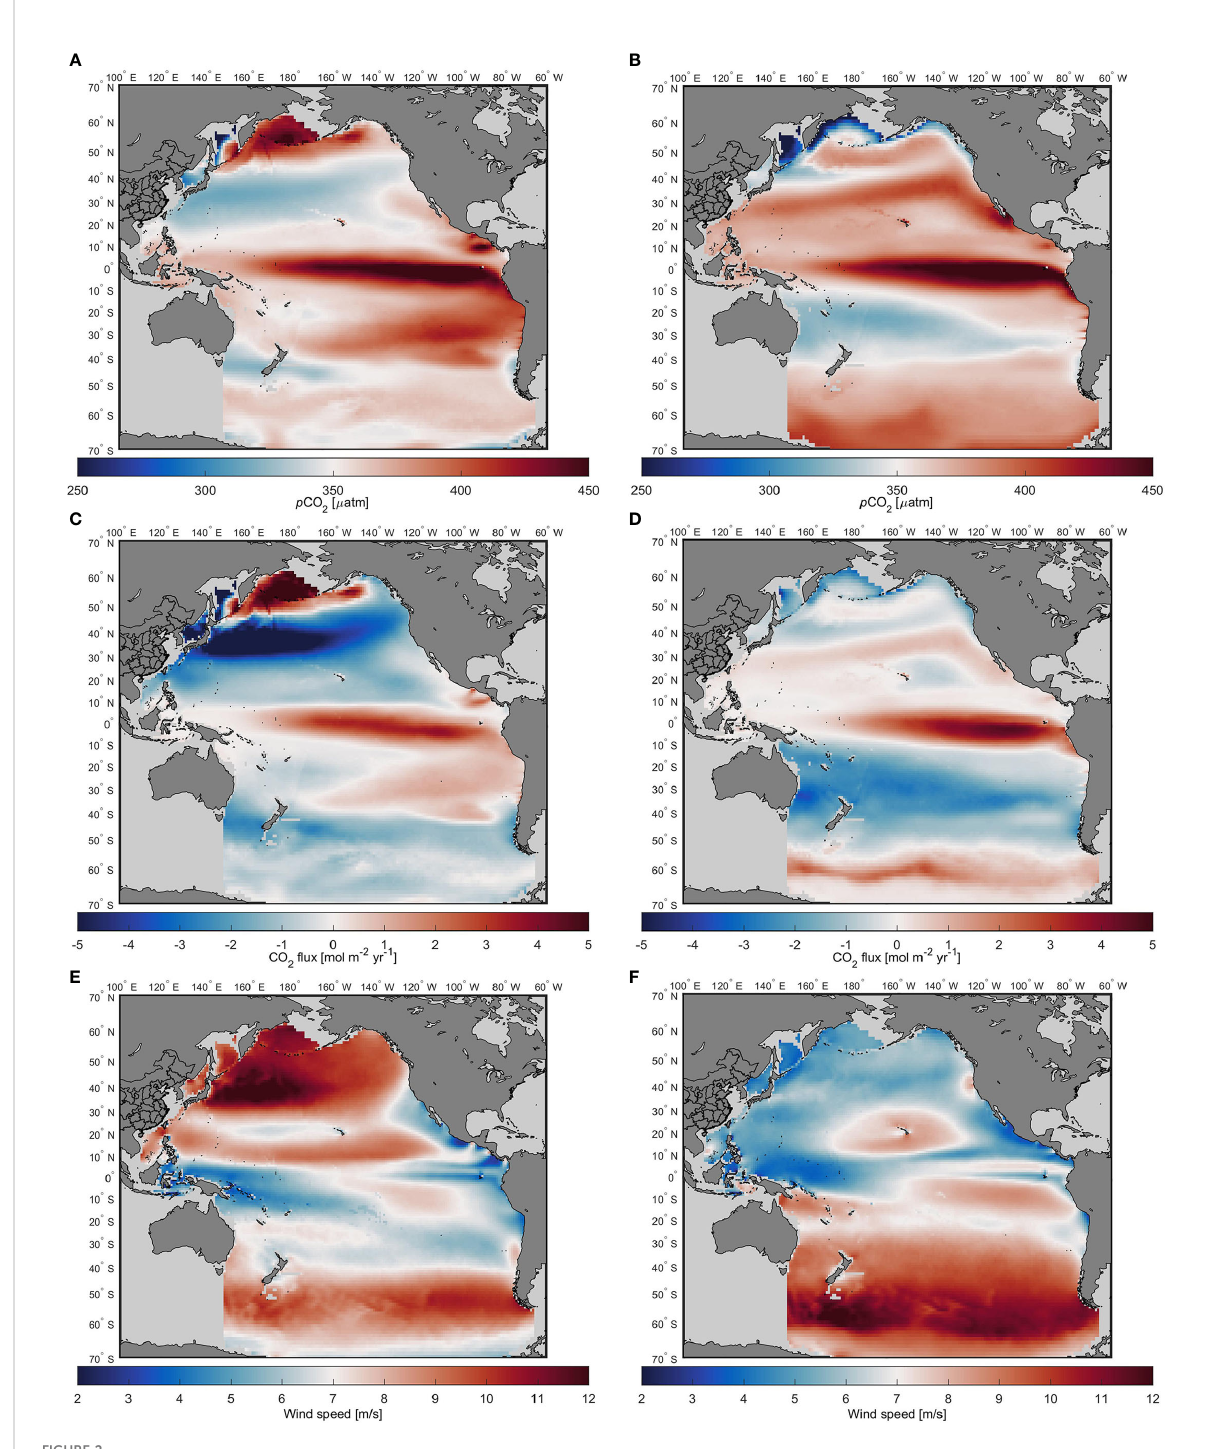
FIGURE 2 Seasonal variability of surface ocean p CO 2 and CO 2 fl ux. (A) and (B) : climatological mean surface ocean p CO 2 in January and July; (C) and fl ux in January and July; (E) and (F) : climatological mean wind speed in January and July from CCMP (D) : climatological mean sea-air CO 2 product (Wentz et al.,